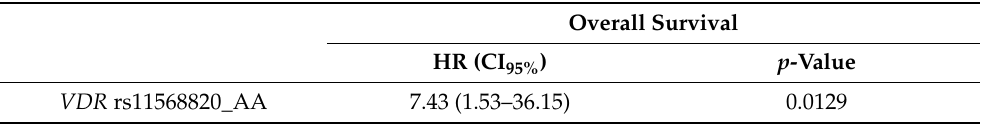
Figure 4. Kaplan–Meier plot of overall survival curves with the G allele of the VDR rs11568820 gene polymorphism in the resected NSCLC subgroup. Table 5. Influence of clinical characteristic and gene polymorphisms on overall survival of resected NSCLC patients.